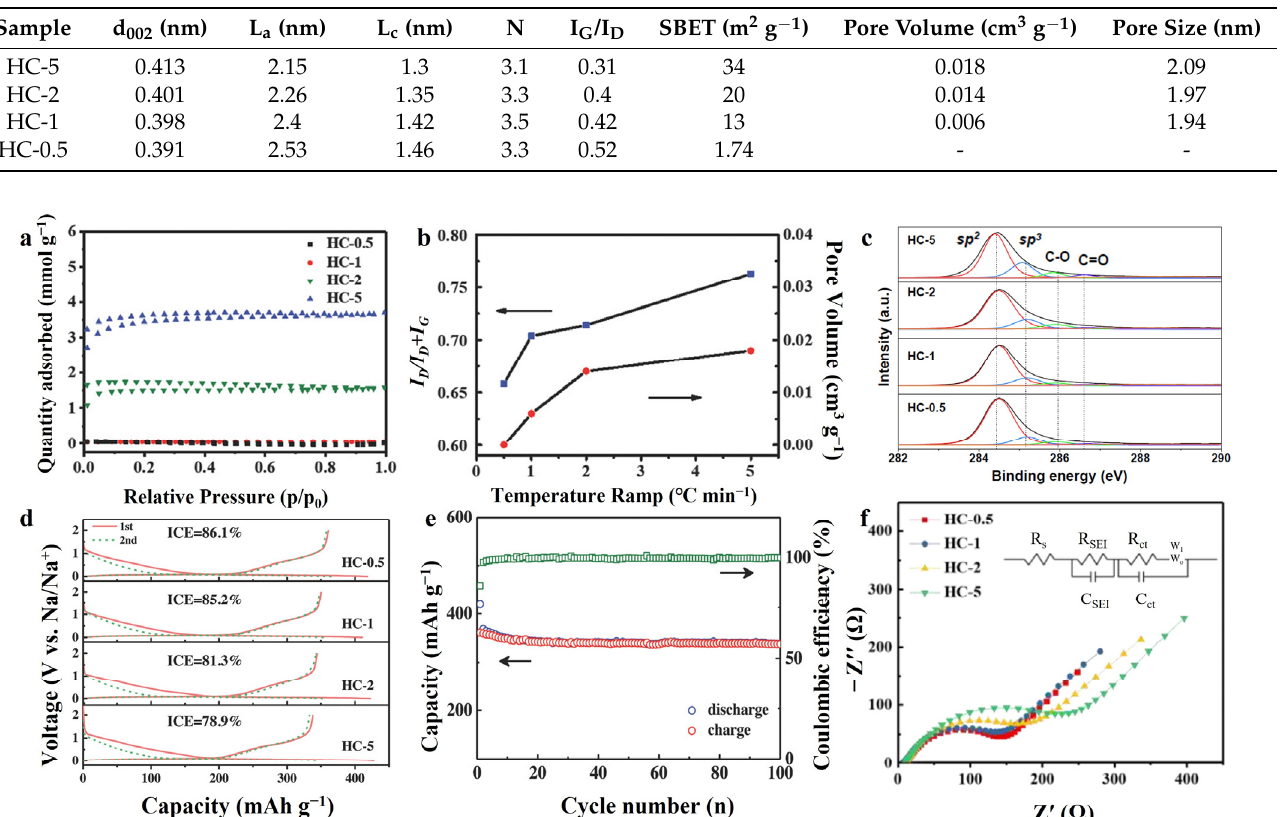
Table 1. Physical parameters for the hard carbon materials [91].